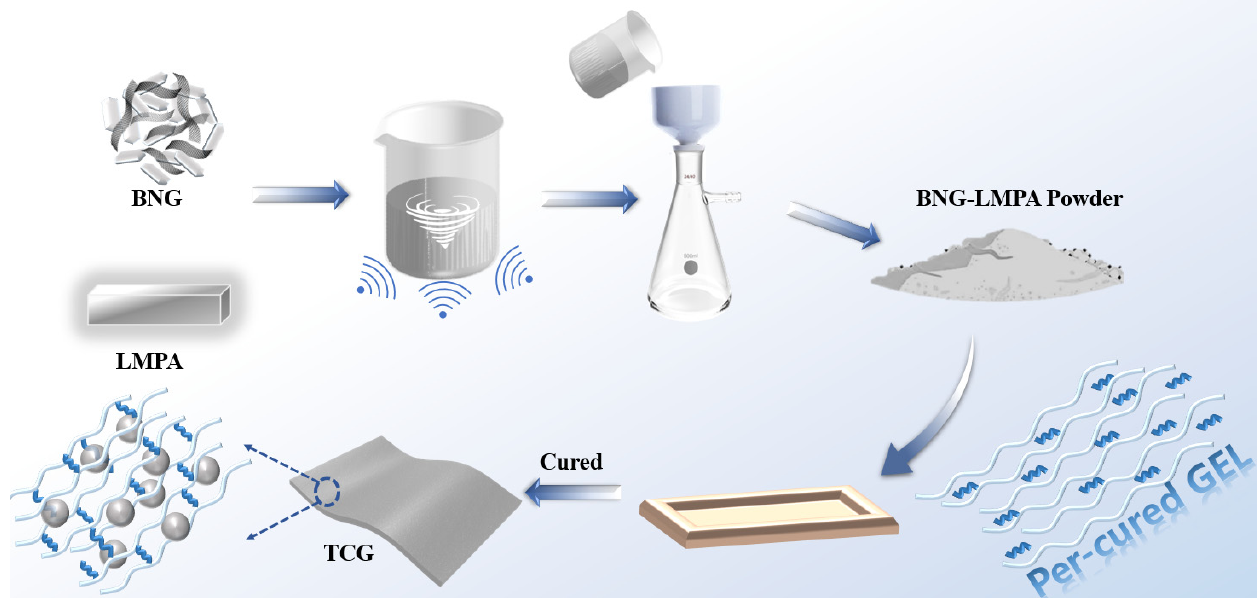
Figure 1. Schematic diagram of the preparation process of BNG-LMPA/SG.